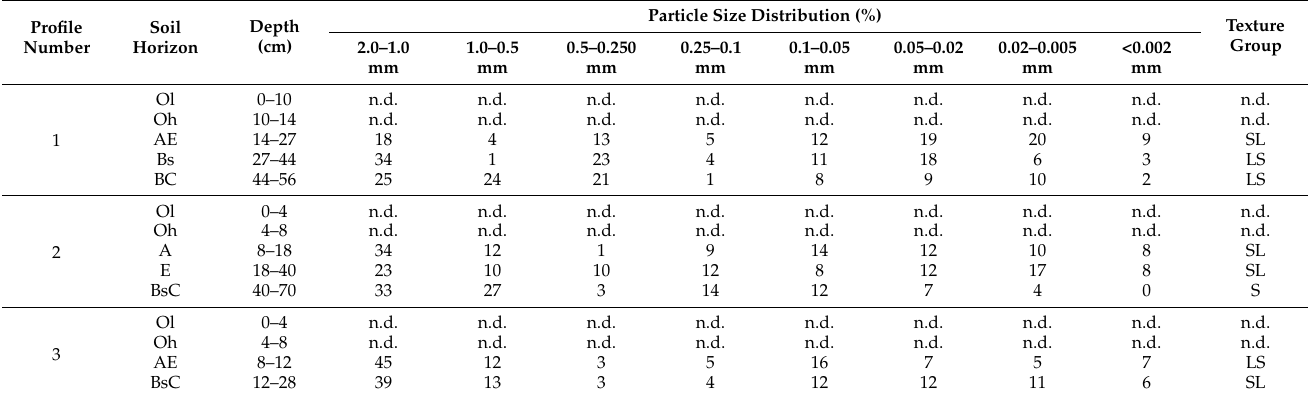
Table A2. Particle size distribution of studied